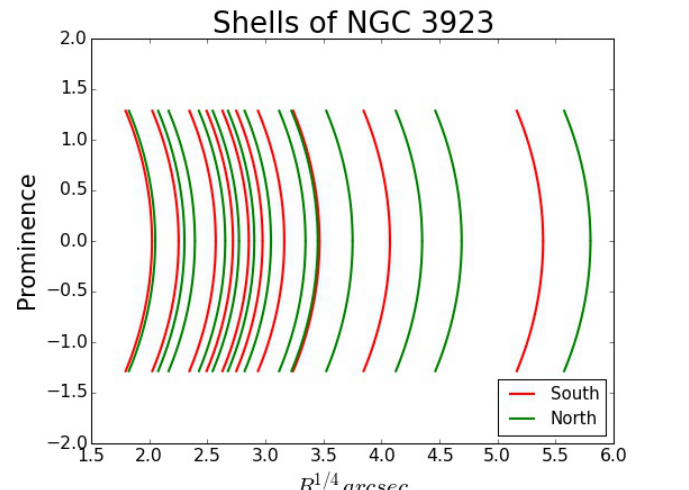
Figure 6. A representation of the interleaving pattern of the shells in NGC 3923. R is the projected radius of the shell rim from the galaxy center. Green arcs indicate shells to the north of the center and red arcs are those to the south. Red and green arcs should alternate, but the outer shells do not follow this